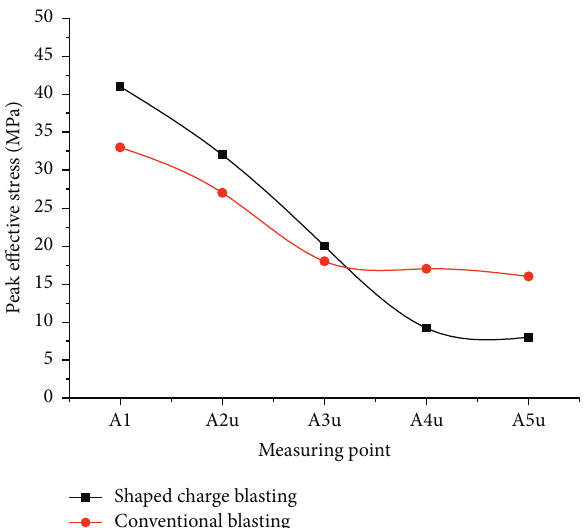
Figure 11: Peak effective stress of measuring point at the blast hole center line.